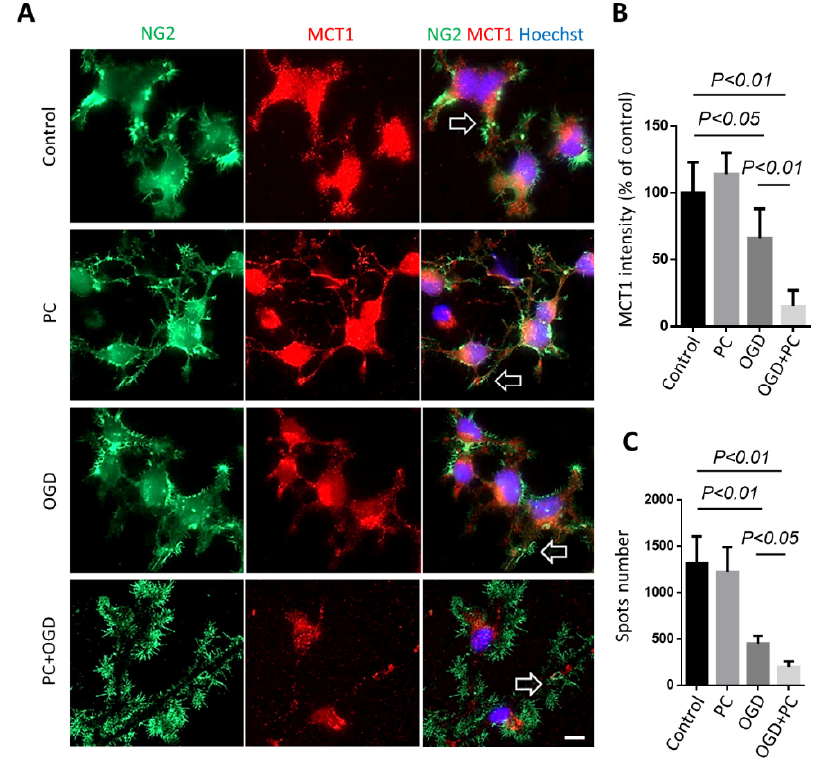
Figure 6. Suppressive effect of lactate utilization of OPCs by preconditioning. ( A ) OPCs were immunostained with NG2 and MCT1 in control, preconditioning only, OGD, and preconditioning + OGD groups, respectively. Signature MCT1 patterns are highlighted with arrows. ( B ) Quantification of relative MCT1 intensity MCT1. ( C ) Quantification of MCT1 spot number on processes in each cell stage. The experiment was performed in triplicate, and 30~50 images were taken for each coverslip. Scale bar = 10 μ m.